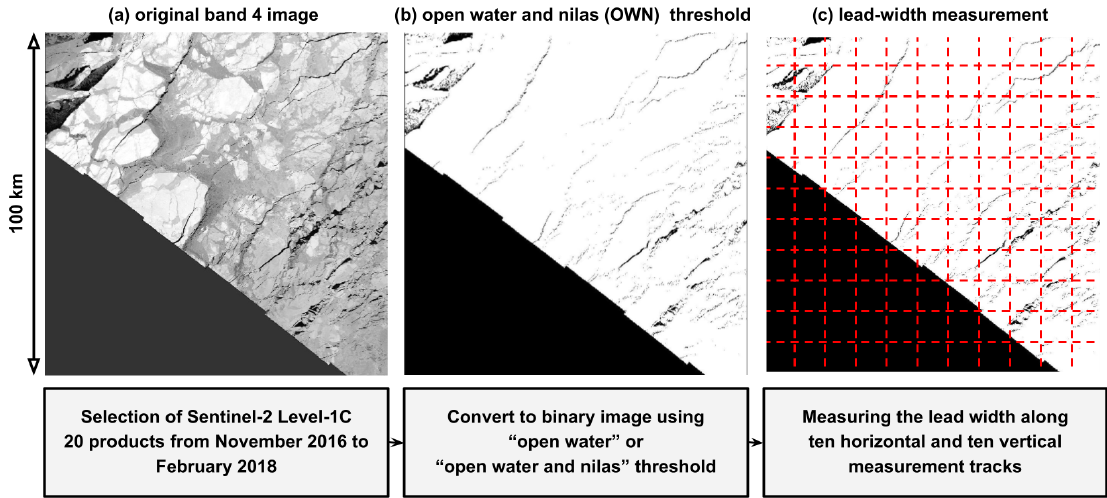
Figure 4. (a) Exemplary original Sentinel-2 Level-1C band-4 image (sensing date: 16 March 2017). (b) Binary image after the application of the open-water-and-nilas (OWN) threshold, where leads are indicated with black pixels and no leads with white ones. (c) Applied mea- surement grid with 10 horizontal and vertical measurement tracks. The swath of the Sentinel-2 satellite does not cover the whole image area defined by the ESA data-processing grid. Thus, only the area covered by the satellite swath is considered for the lead-width measurement.